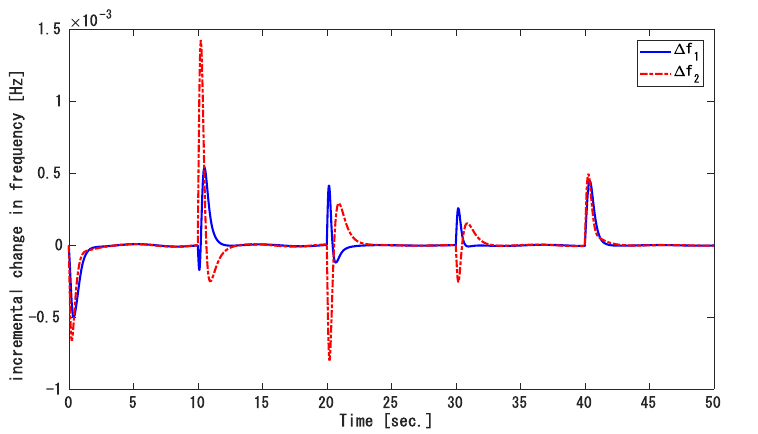
Figure 9. The frequency variation.